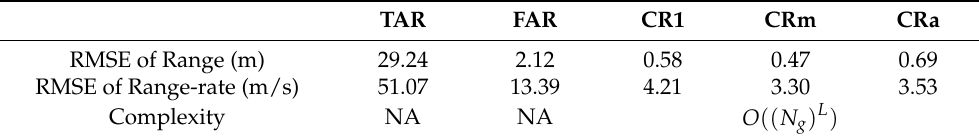
Table 1. Comparison between the TAR, FAR, and CR versions [17]. TAR FAR CR1 CRm CRa RMSE of Range (m) 29.24 2.12 0.58 0.47 0.69 RMSE of Range-rate (m/s) 51.07 13.39 4.21 3.30 3.53 Complexity NA